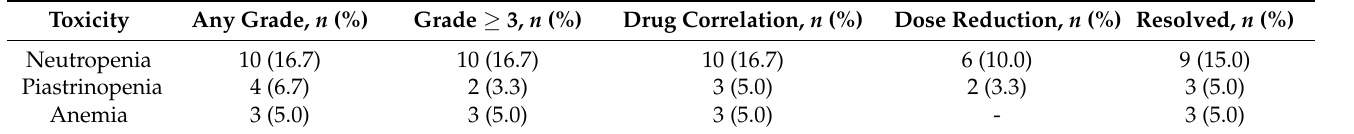
Table 3. Hematological adverse events